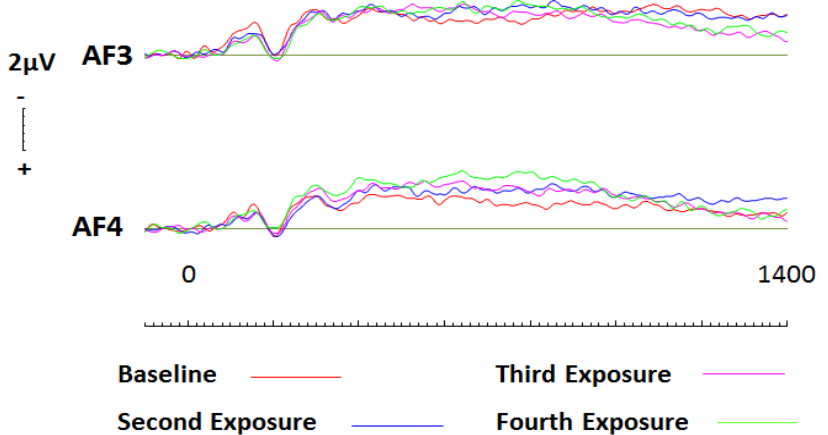
Figure 9. ERPs generated at site P6 during baseline recording for liked, disliked, and filler brands. Disliked brands were seen to elicit significant less activity than liked or neutral brands.